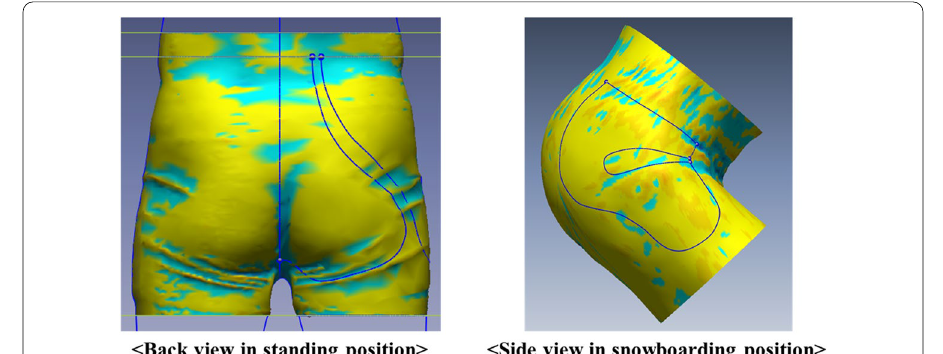
Fig. 2 Mean curvature of mean 3D human data